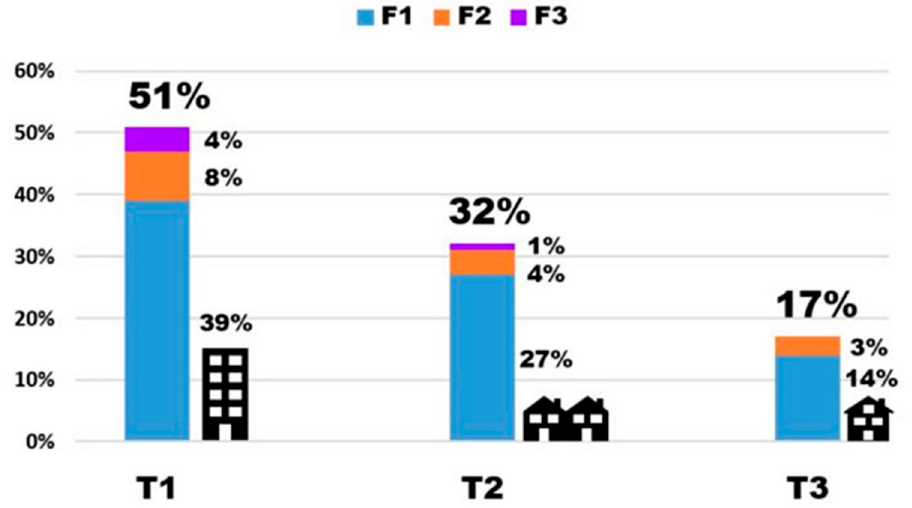
Figure 4. Association between the type of fault and the type of dwelling.